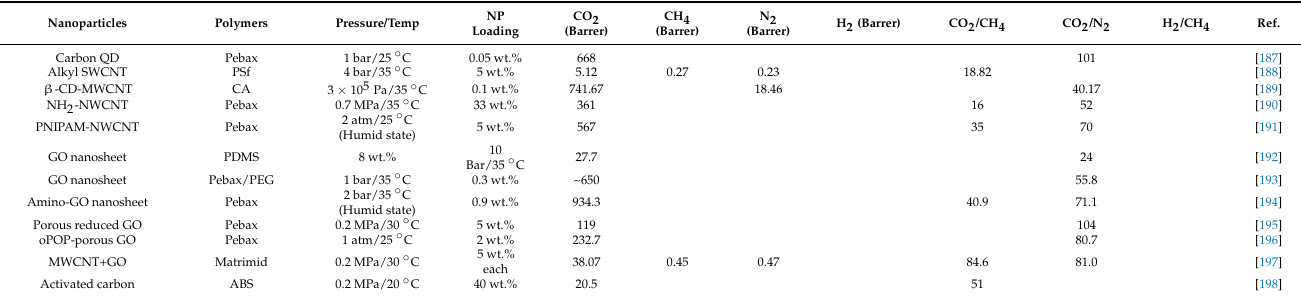
Table 6. Transport properties of nanocarbon/polymer mixed matrix membranes.